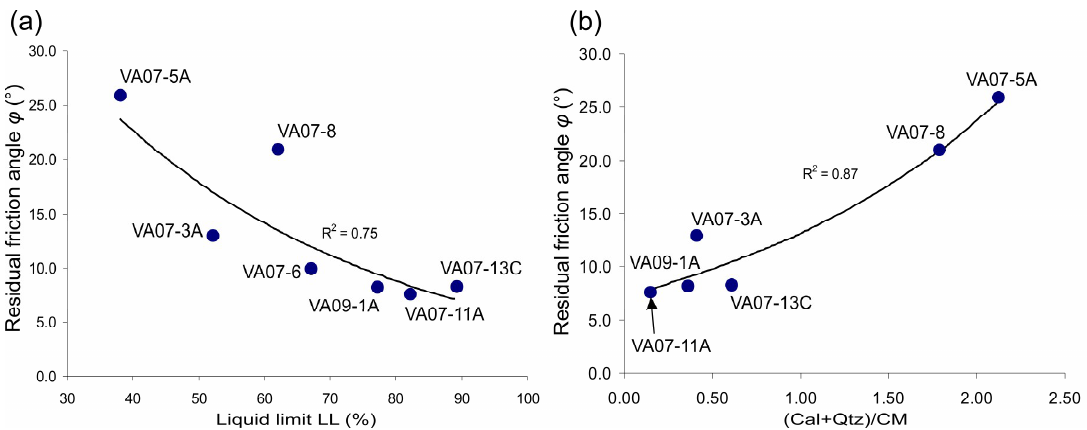
Figure 11. Correlation diagrams for some selected clay samples from Vajont, showing ( a ) residual friction angle vs. liquid limit and ( b ) residual friction angle vs. (calcite + quartz)/clay minerals ratio.